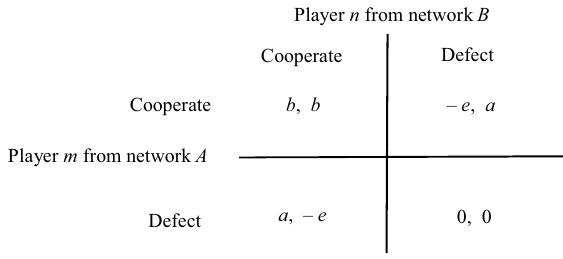
Fig. 1. Payoffs from market